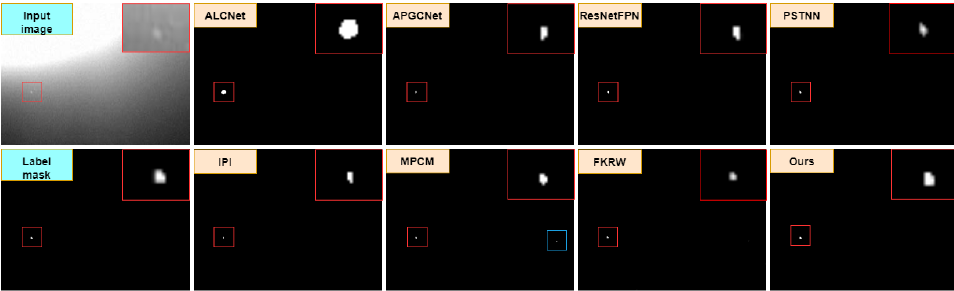
Figure 8. Detection results of infrared small targets in Scene 1 using different detection methods. The target area is enlarged for better display. Red and blue squares represent correct targets and false alarms, respectively.